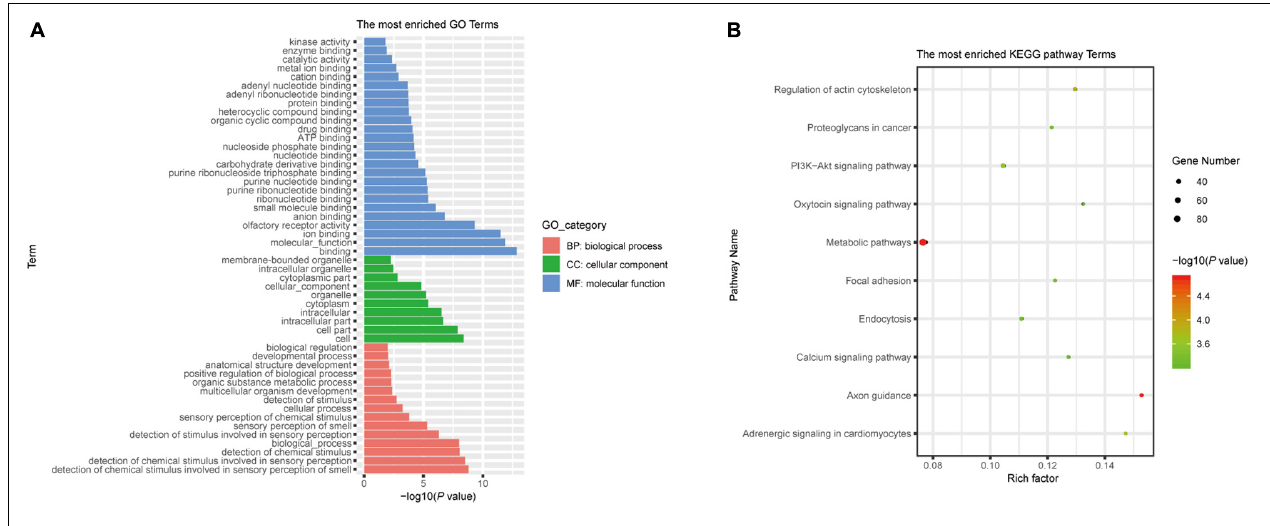
FIGURE 2 | Bioinformatics analysis of predicted target genes of LDEVs-associated sRNA71. The graphs were made with R package “ggplot2” (version 3.6.1). (A) Top 50 correlative GO terms of potential target genes of sRNA71. Selected terms were divided into three major categories, including biological process, cellular component, and molecular function. (B) The most enriched KEGG pathways of candidate genes were targeted by sRNA71 ( P < 0.001). Counting the number of candidate genes was served as “Gene Number,” which divided by total number of genes in this pathway equals “Rich